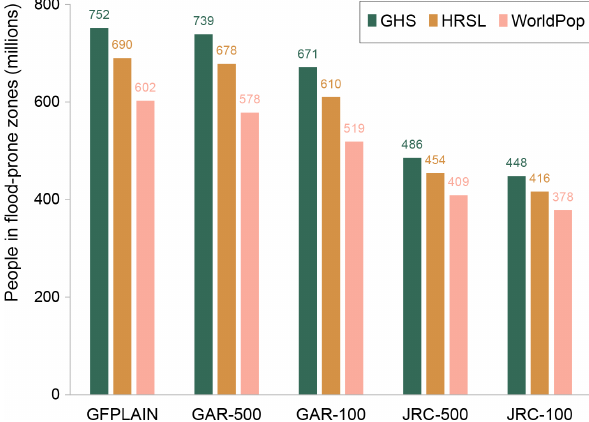
Figure 6. Total exposed population (millions) across all 26 coun- tries, comparing the hydrogeomorphic floodplain map GFPLAIN with the flood hazard maps the GAR and JRC with 100- and 500- year return periods. The population estimates are given by the Global Human Settlement population grid, the High Resolution Settlement Layer, and WorldPop. The floodplain map GFPLAIN yields the highest exposure estimates even though GAR-500 covers a slightly larger total area. The choice of flood and population maps affects the results more than the choice of the return